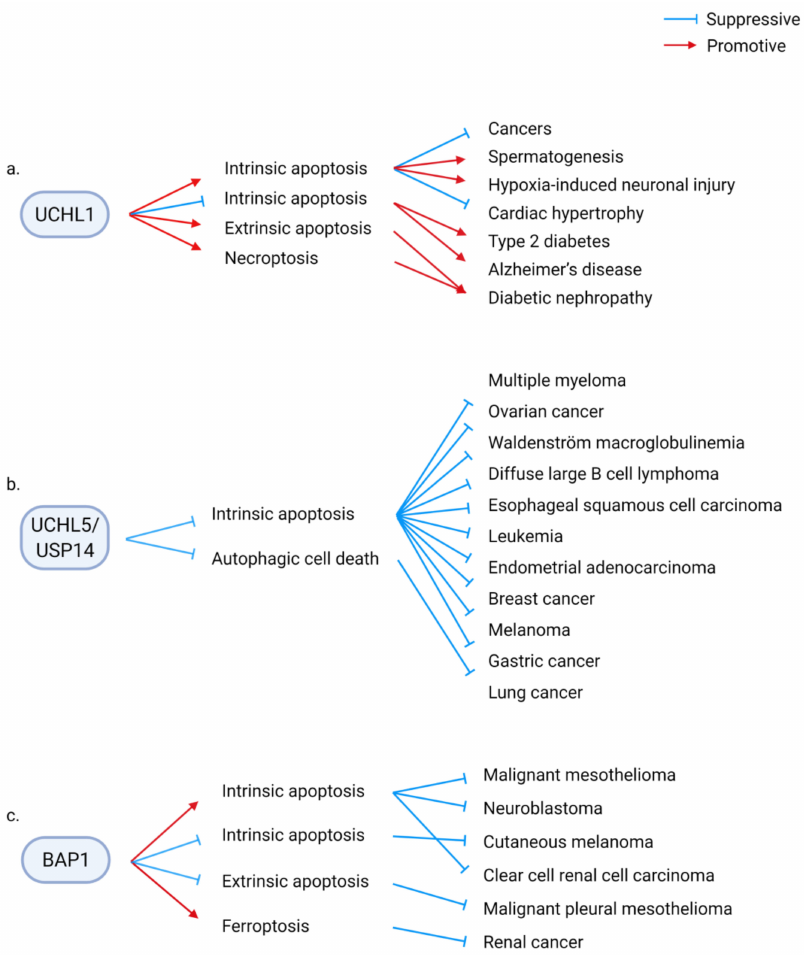
Figure 4. Examples of diverse pathophysiological consequences of deubiquitinase (DUB)/regulated cell death (RCD) regulatory axes. DUBs are involved in diverse pathophysiologi- cal conditions through the modulation of different types of RCD. ( a ) UCHL1 enhances or suppresses intrinsic apoptosis, extrinsic apoptosis, and necroptosis. The UCHL1/RCD axis aggravates or allevi- ates malignant diseases, tissue injury, metabolic disorders, and degenerative diseases and is required for spermatogenesis. ( b ) UCHL5/USP14, which are the proteasomal DUBs, aggravate several types of cancer by suppressing cell death. The anticancer potential of the inhibitors of UCHL5 and USP14 has been examined. ( c ) On the contrary, the tumor suppressor, BAP1, promotes or suppresses tumorigenesis by regulating various types of